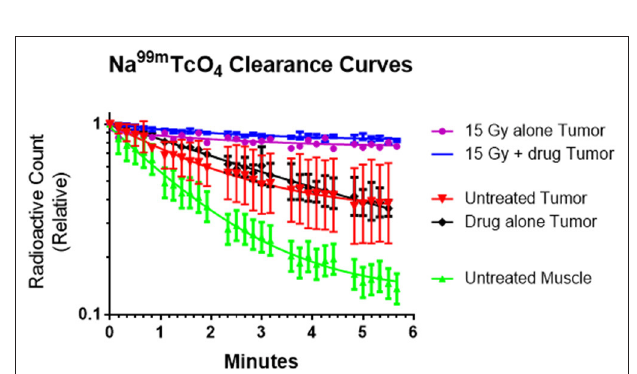
FIGURE 3 | The rate of sodium pertechnetate (Na 99m TcO 4 ) clearance following a local injection was used as a surrogate of blood flow. The radiotracer cleared slowly after high single dose radiation (15Gy) with or without metformin indicating that the radiation reduced tumor blood flow within an hour of exposure. We hypothesize that decreased blood flow adversely affected tumor microenvironment and enhanced cytotoxicity of metformin. In contrast, radiotracer cleared rapidly from untreated tumors, drug alone tumors and especially normal muscle (control study). Average values ( n = 2), error bars representing standard deviations and best fit lines assuming a single exponential decay are shown.